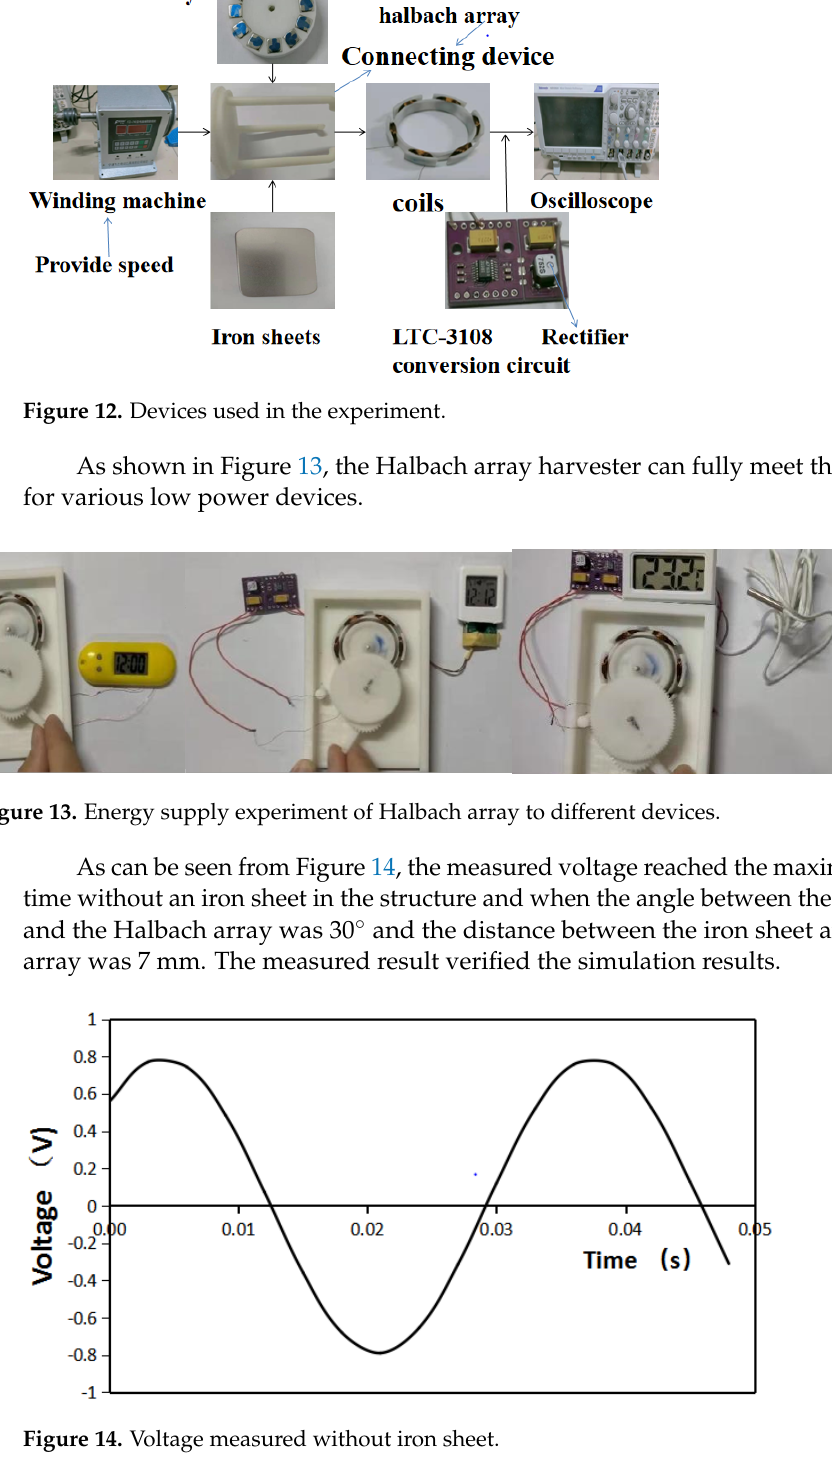
Figure 14. Voltage measured without iron sheet.